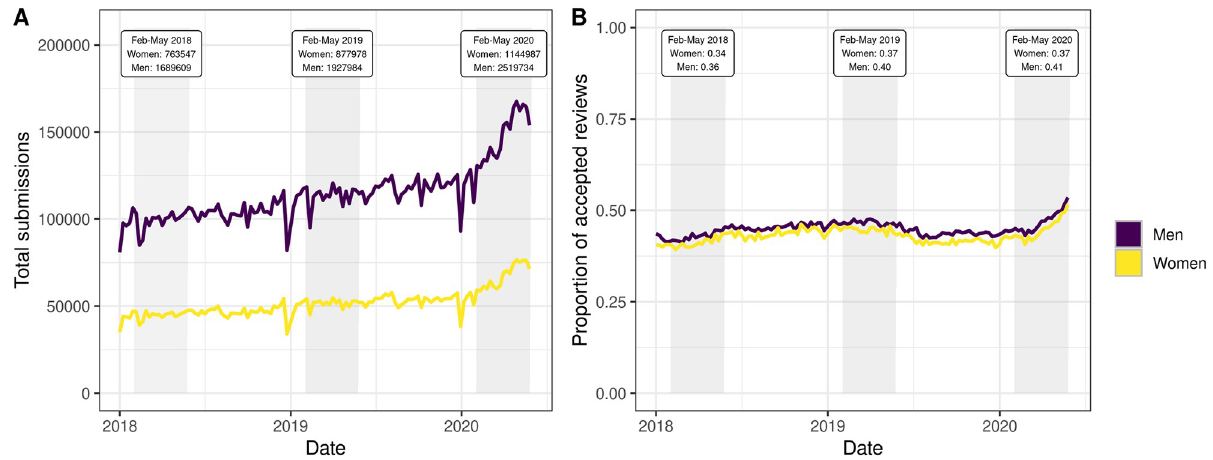
Fig 1. Total submissions (A) and proportion of accepted reviews (B) per week across the whole period covered by the dataset. The shaded areas indicate the February-May period of each year considered in the analysis. Note that in panel A co-authored submissions were reported multiple times depending on the number of co-authors. Each author or referee whose gender was not successfully guessed by our algorithm was